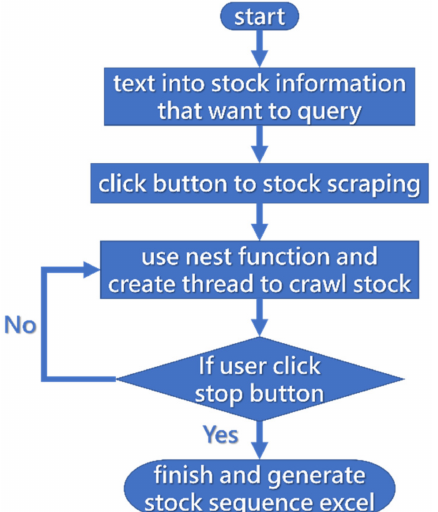
Figure 8. Flow chart of thread and nest function to mine stock